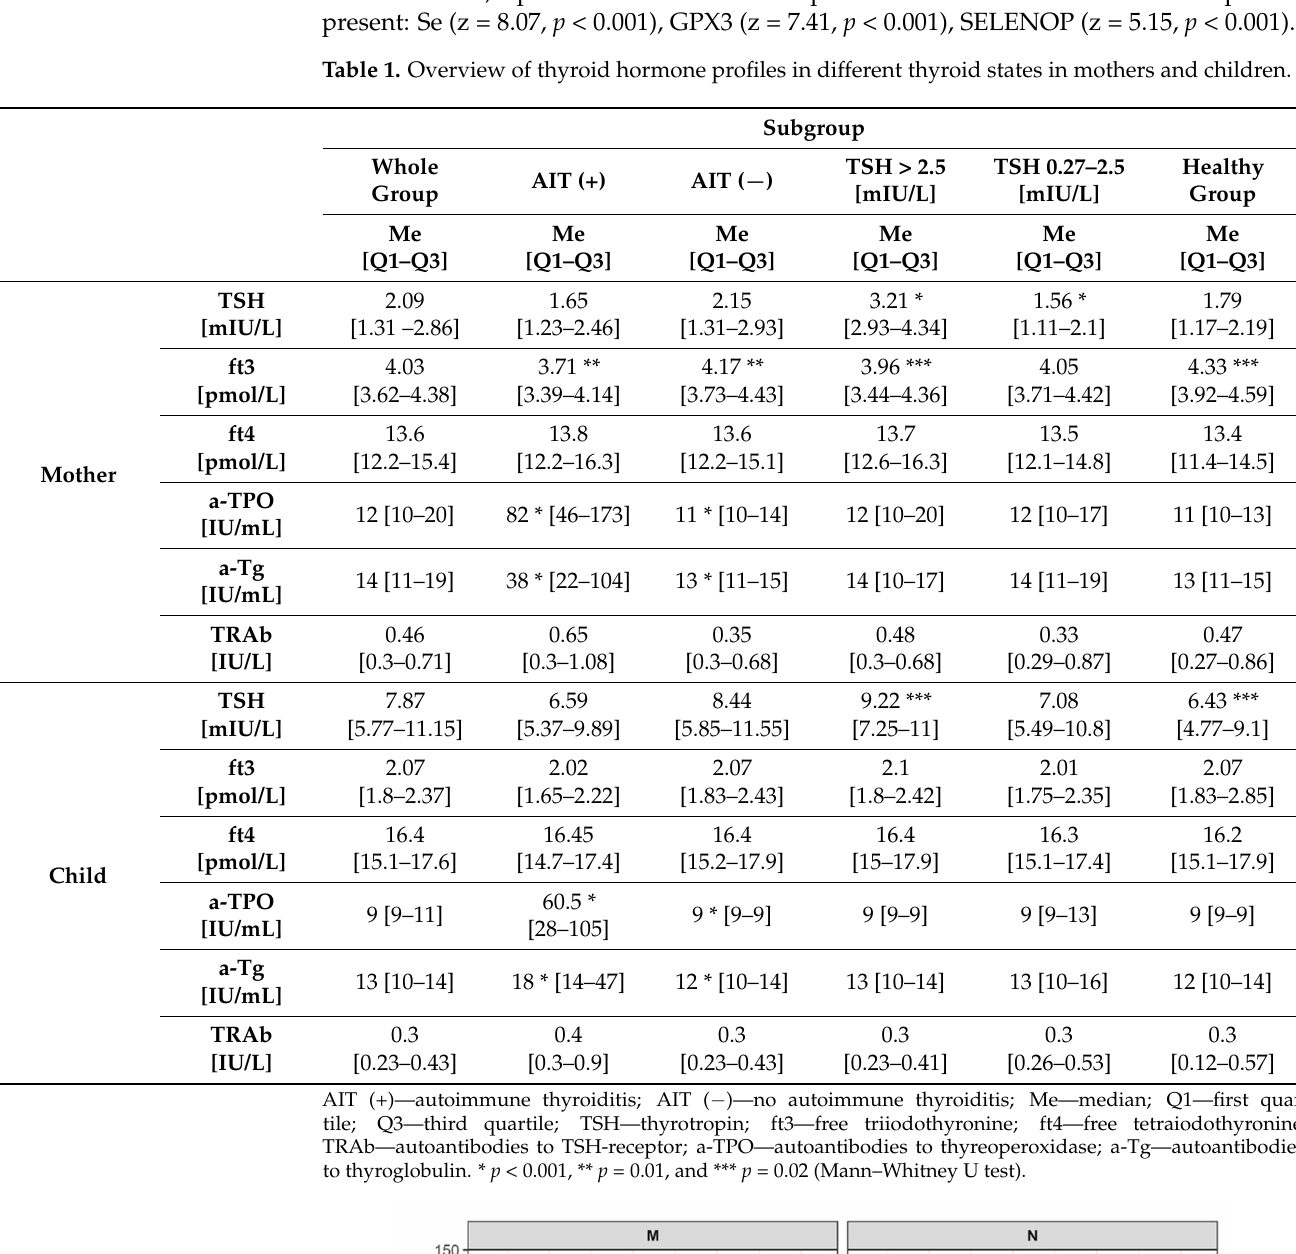
Figure 2. Correlation analysis of Se status biomarkers in the mothers and the newborns. Significant positive correlations were observed for all three biomarkers in all possible combinations, both in the full cohort of samples as well as in the groups of mothers (M, left panel) and newborns (N, right panel) separately. The linear positive correlation of ( A ) Se with SELENOP was most pronounced and stringent, in particular in newborns. ( B ) Serum Se and GPX3 activity correlated to a similar extent as ( C ) SELENOP and GPX3 activity. Correlation analyses conducted by Spearman’s R test; linear regression results are indicated as red lines with the 95% confidence intervals as green shad- ows. 3.3. Selenium Status in the Mothers and the Newborns The entire collection of serum samples was analyzed for both total Se and SELENOP concentrations and classified according to the thresholds of deficiency. Using a commonly used cut-off for serum Se of 70 µg/L, the majority of samples were classified as Se-deficient (Figure 3A,B). Choosing a more stringent threshold, a fifth of the mothers and four-fifth of the newborns were severely deficient and displayed Se concentrations below 45.9 µg/L. A similar picture was obtained by SELENOP analysis. Taking the 95%-reference range of healthy European adults as threshold, three-quarters of all samples (77%) was below the 2.5th centile, i.e., below the threshold for deficiency (Figure 3A,B). Comparing the classi- fication according to the total serum Se deficiency and SELENOP deficiency, the results are highly congruent with few exceptions only (Figure 3C). The differences observed may be associated with the recent dietary or supplemental Se intake, which would directly affect the total serum Se concentrations, although they would not immediately impact acute circulating SELENOP levels.